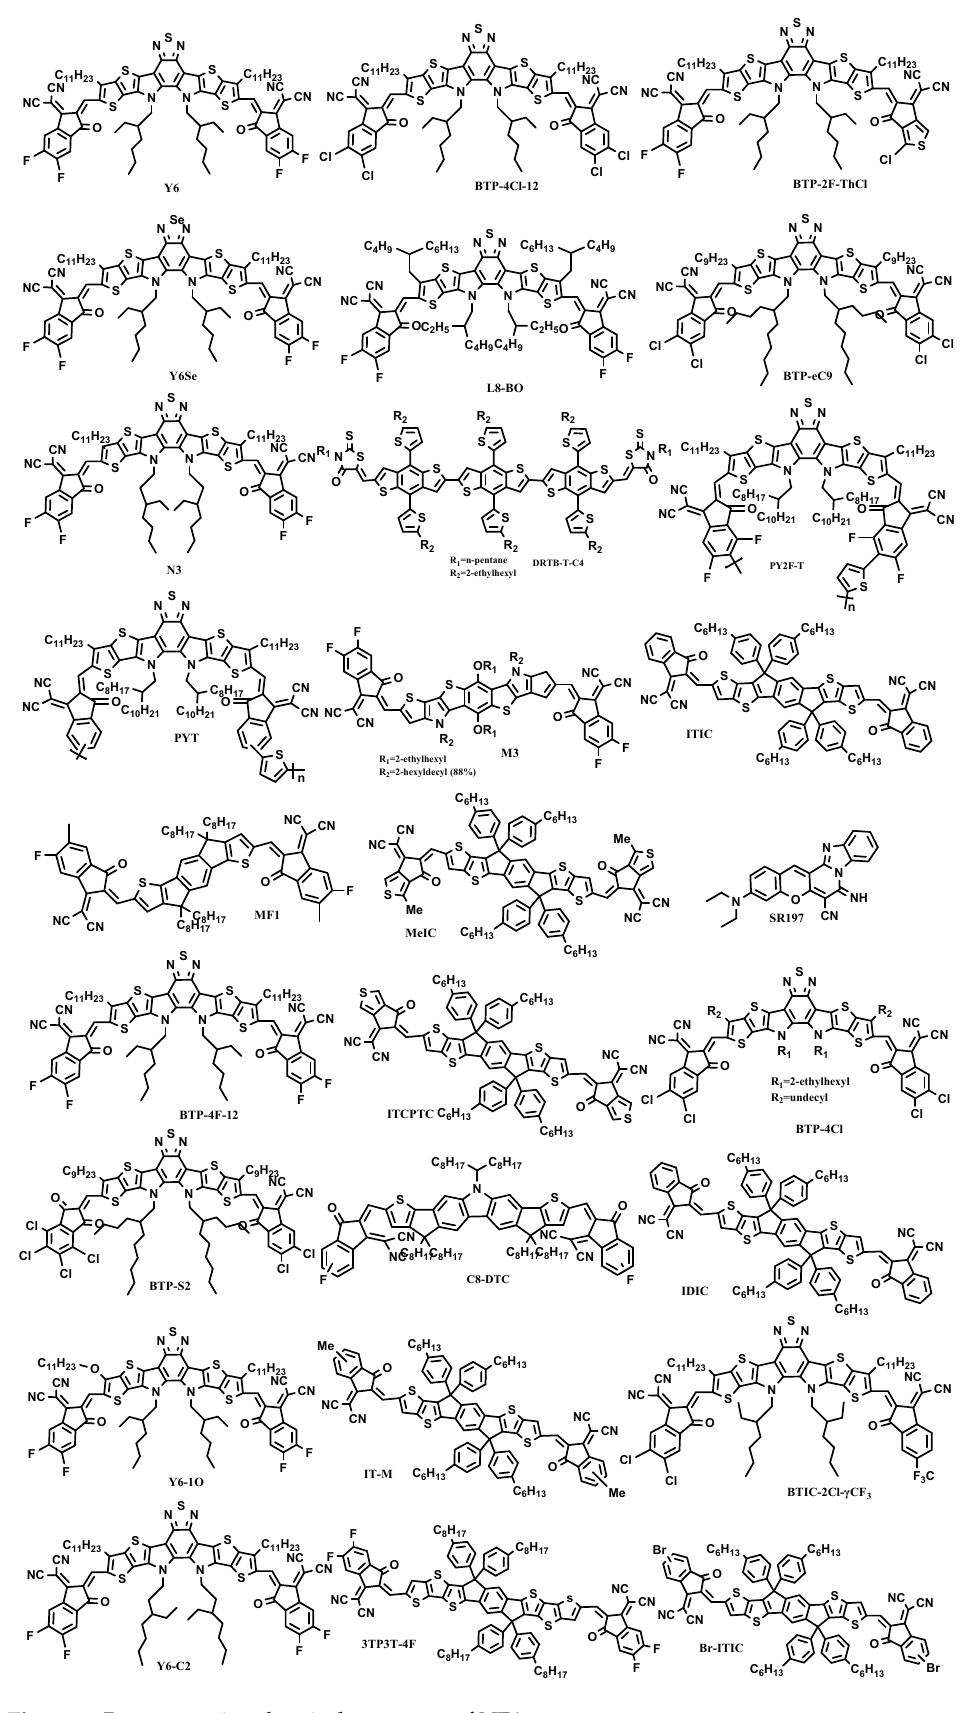
Figure 3. Representative chemical structures of